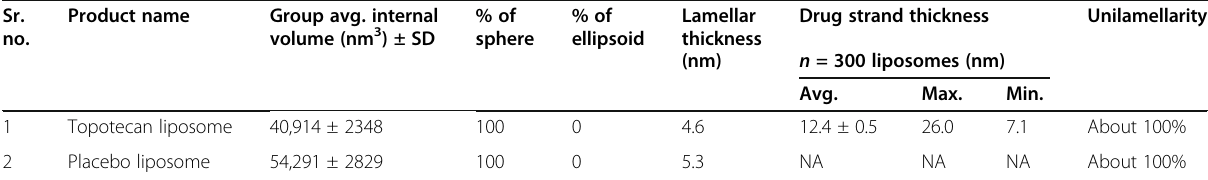
Table 6 Summary of findings in Cryo-TEM analysis Sr.